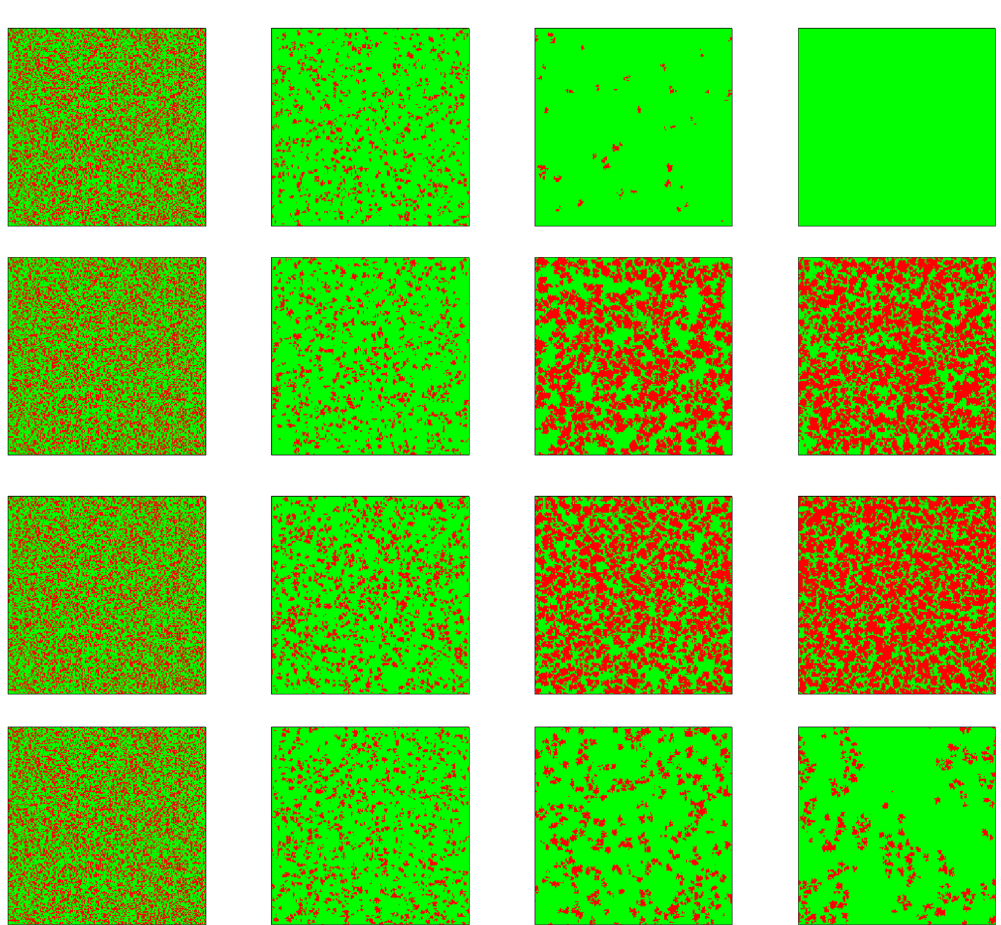
Figure 3. Typical snapshots of the distribution of strategy in step 0, 10, 100, 30000. All results are obtained for ε = . 0 8 and = . b 1 06 . From top to bottom, δ are equal to 0, 0.01, 0.05, and 0.2 respectively. Cooperators and defectors are marked by red and